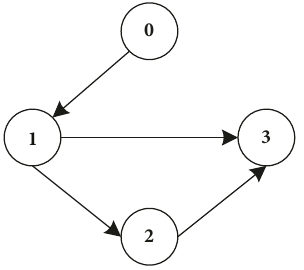
Figure 1: Example graph and the according Laplacian matrix.